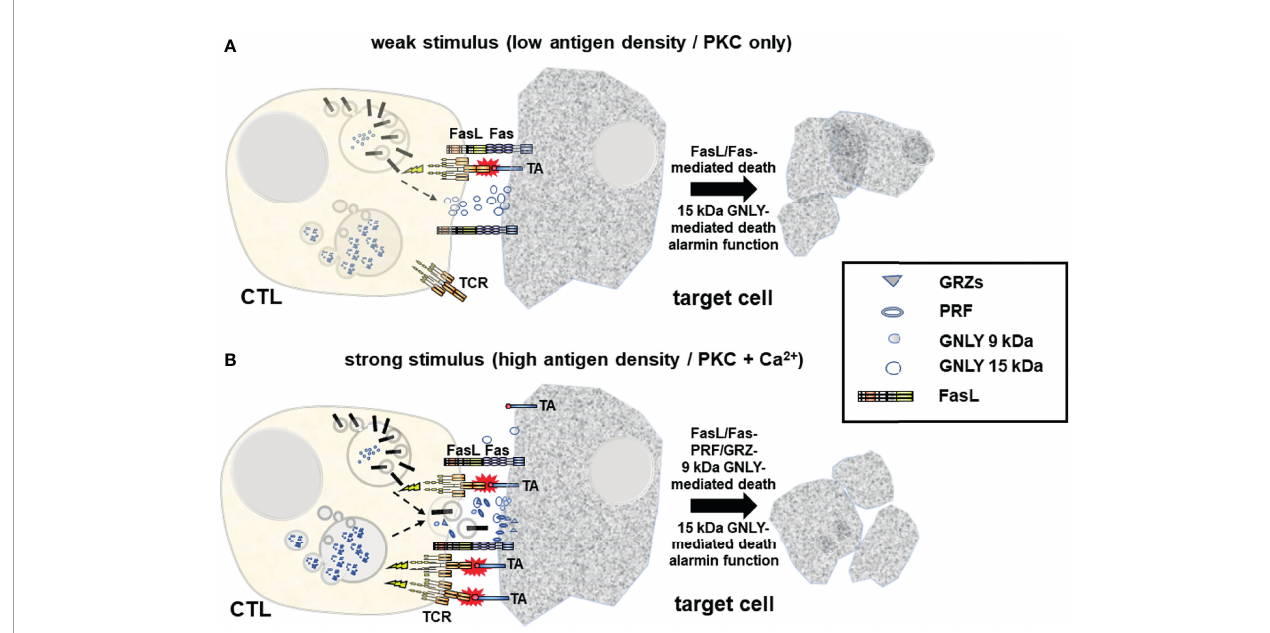
FIGURE 1 | Upon target cell encounter LREV/MVB are mobilized to the site of intercellular contact where they fuse with the membrane to release cytotoxic effector molecules into the forming immunological synapse and to expose transmembrane death factors (e.g. FasL) locally on the cell surface. (A) At weaker stimuli (e.g. low antigen density on the target cell) and in the absence of Ca 2+ signaling, FasL and 15 kDa GNLY are mobilized from light LREV in a PKC-dependent non-classical degranulation process exposing FasL locally on the plasma membrane and releasing 15 kDa GNLY into the immunological synapse. FasL induces cell death in Fas + target cells. At the same time, 15 kDa GNLY might act as a supporter of cytolysis but also as an alarmin to recruit more immune cells to the site for immunosurveillance. It is unclear to date whether FasL + exosomes are also released in response to weak stimuli. (B) In response to strong stimuli (e.g. high tumor antigen (TA) density), additional Ca 2+ signaling triggers the release of prestored soluble cytotoxic effector molecules including PRF, GRZs and 9 kDa GNLY from dense MVBs. This process is generally referred to as classical degranulation. At the same time, the death factor FasL and the 15 kDa GNLY are also mobilized. The composition of cytotoxic effectors released in a given situation might thus dictate the characteristics of the cell death program executed in different target cells with respect to immunogenicity and further surveillance or